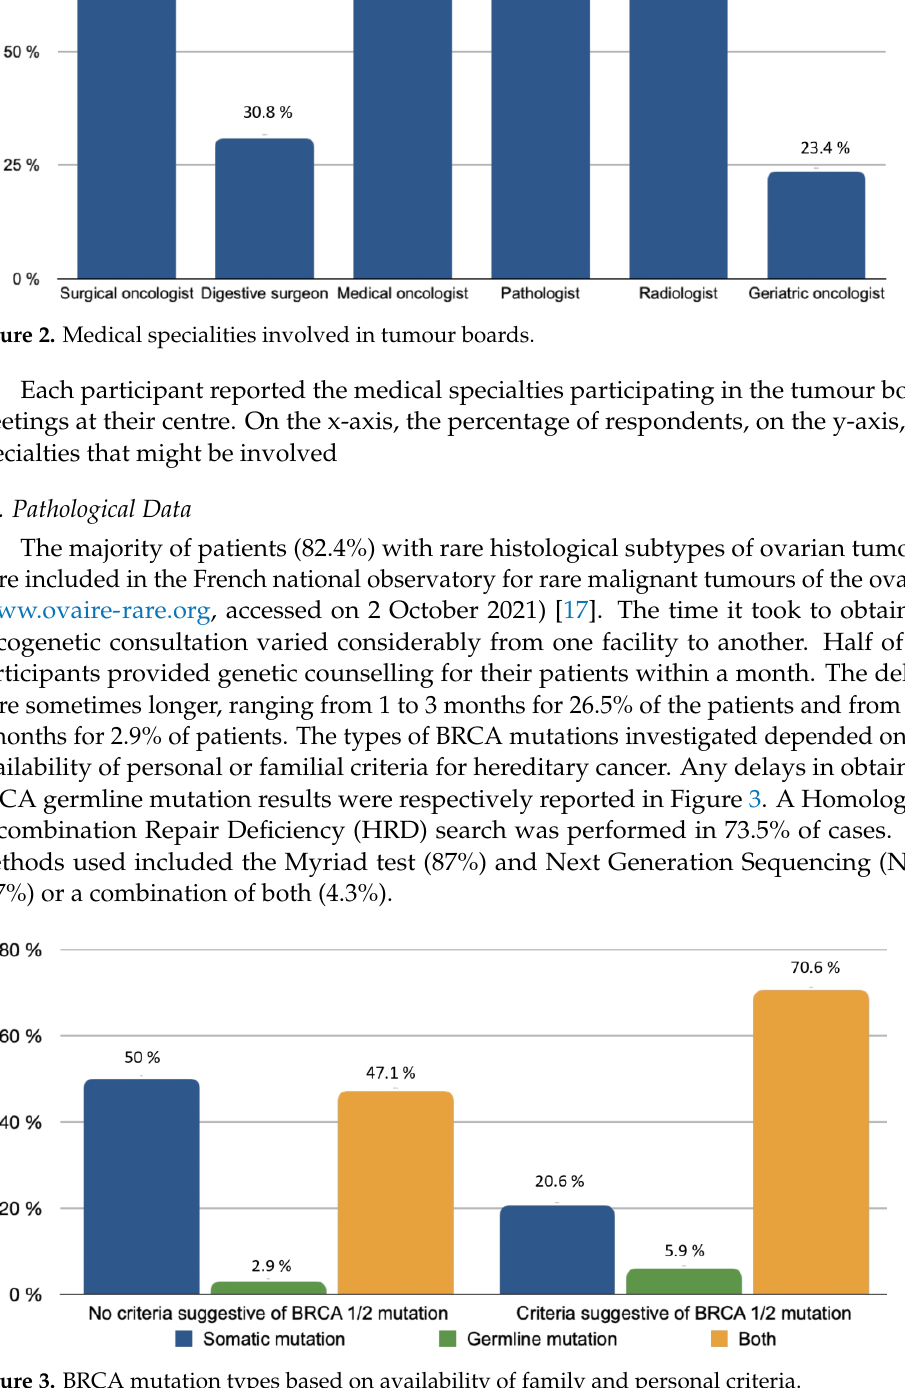
Figure 3. BRCA mutation types based on availability of family and personal criteria.